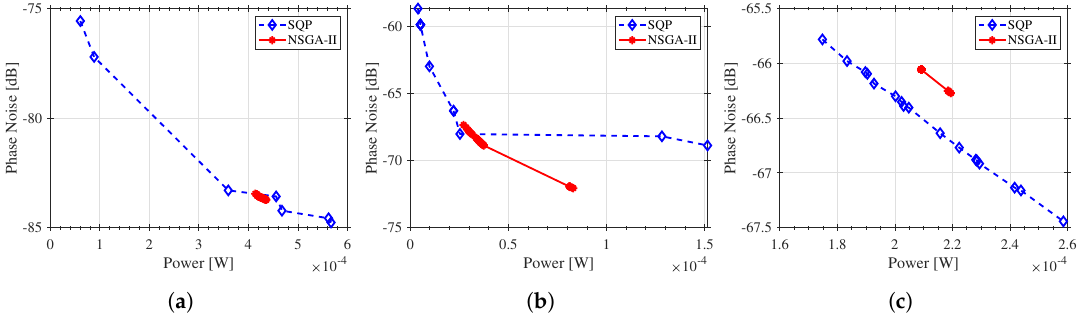
Figure 14. Pareto front of the optimization of the CSVCO circuit using SQP and NSGA-II optimization algorithms and ( a ) TSMC 180 nm process. ( b ) IBM 130 nm process. ( c ) TSMC 65 nm CMOS process.